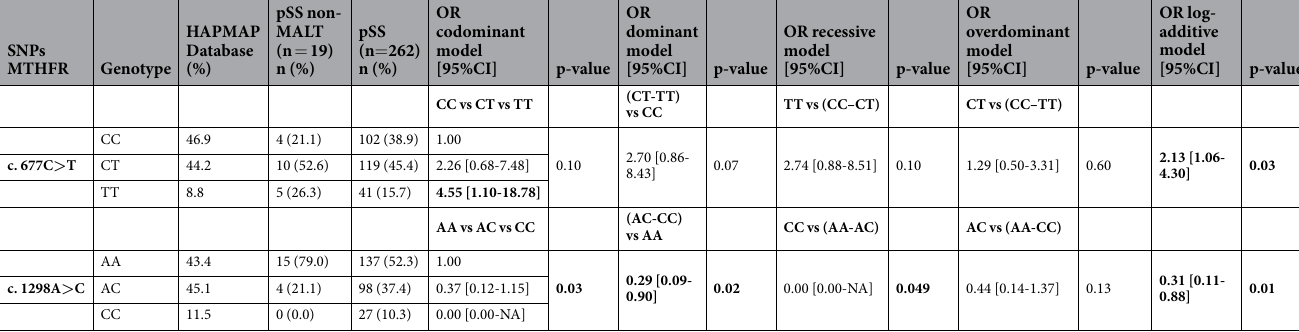
Table 1. Prevalence of MTHFR genotypes in pSS non-MALT and pSS patients, adjusted by gender and age. Genotypes, OR and p-value for the five genetic models (codominant, dominant, recessive, overdominant and additive) were estimated with SNPstats software (statistically significant if p < 0.05). MTHFR: methylene tetrahydrofolate reductase, pSS: primary Sjogren’s syndrome, MALT: mucosa-associated lymphoid tissue, OR: odds ratio, SNP: single nucleotide polymorphism, VS: versus, HAPMAP: haplotype map.